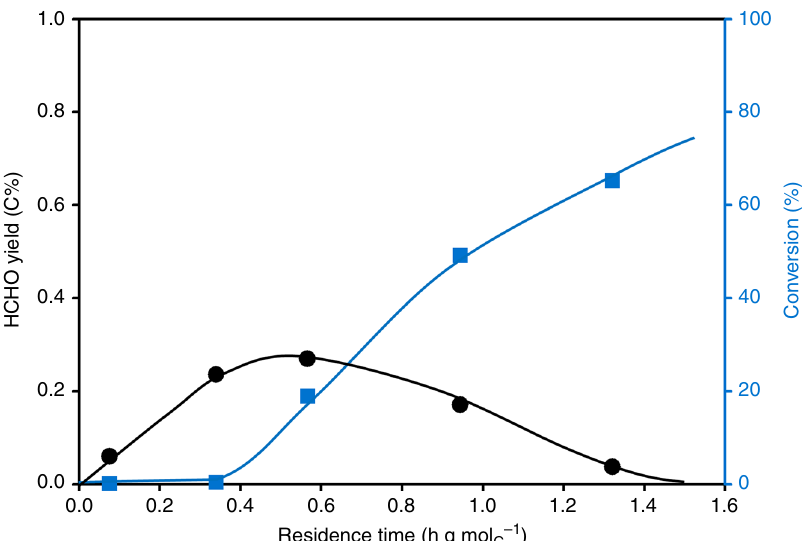
Fig. 1 Methanol conversion and the yield of HCHO as a function of residence time. Reaction conditions: DME 90 mbar, H-ZSM5 (Si/Al 90 steamed) 475°C